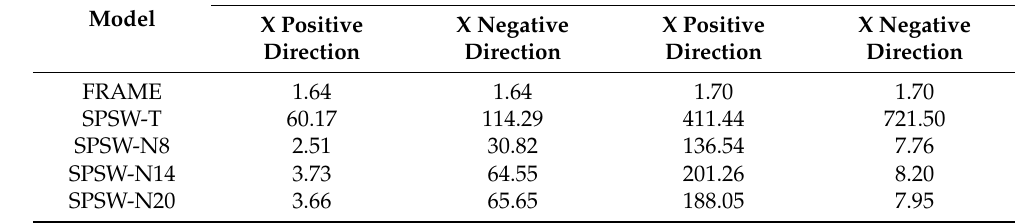
Table 10. Maximum out-of-plane displacement of the frame of each model without frame beam flange constraints at a drift ratio of 0.025 (unit: mm). In Pull Direction of the Loading End In Push Direction of the Loading End Model X Positive X Negative X Positive X Negative Direction Direction Direction Direction